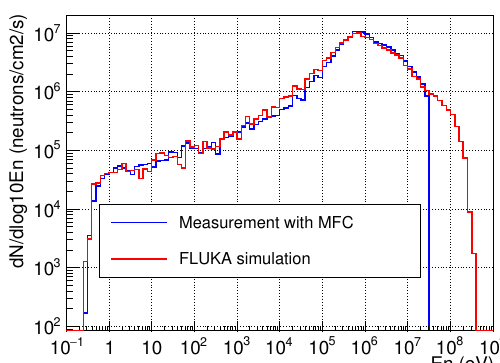
Figure 7: The comparison of the measured and simulated neutron energy spectrum of CSNS Back-n #ES1 at 100 kW with 10 bpd with energy logarithmic scale.